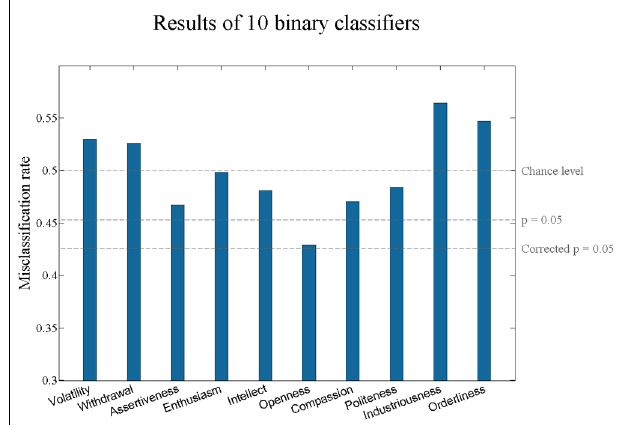
FIGURE 2 | Misclassification rates of lower-order aspects of Big Five personality traits. The aspect scores have been binarized with a median-split. Although the p -value of the misclassification rate for Openness is below 0.05, it does not remain significant after Bonferroni or false discovery rate